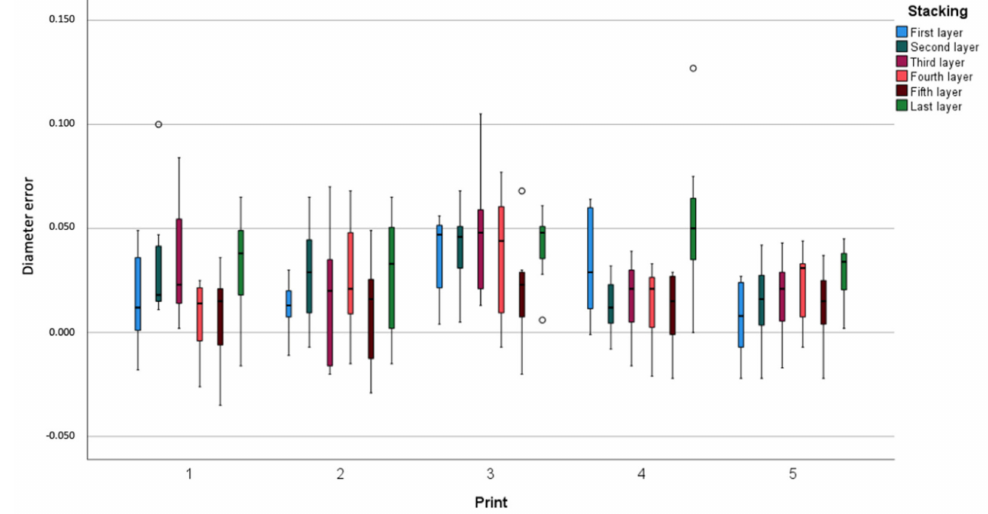
Figure 2. Dimensional error (diameter error of the spheres) in relation to stacking (model) and print. Measurements in millimetres.